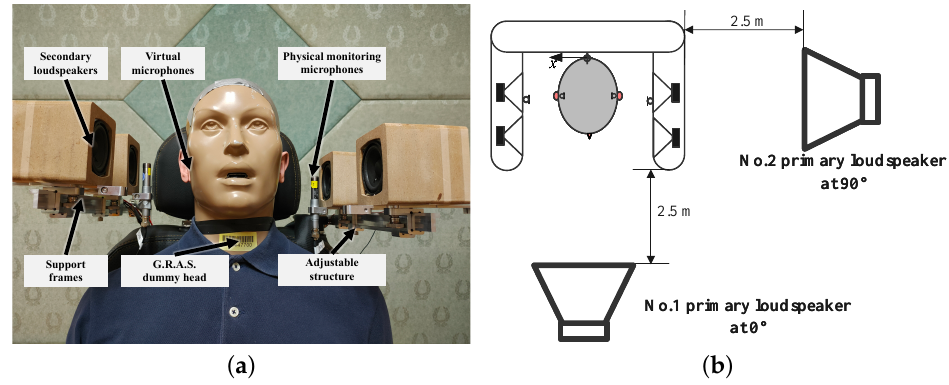
Figure 5. Overall setup of the proposed active headrest system with two primary loudspeakers. ( a ) Active headrest system with two secondary loudspeakers and a physical microphone on each side. ( b ) Schematic of experimental measurement configuration with two primary loudspeakers at 0 ◦ and 90 ◦ relative to the dummy head.